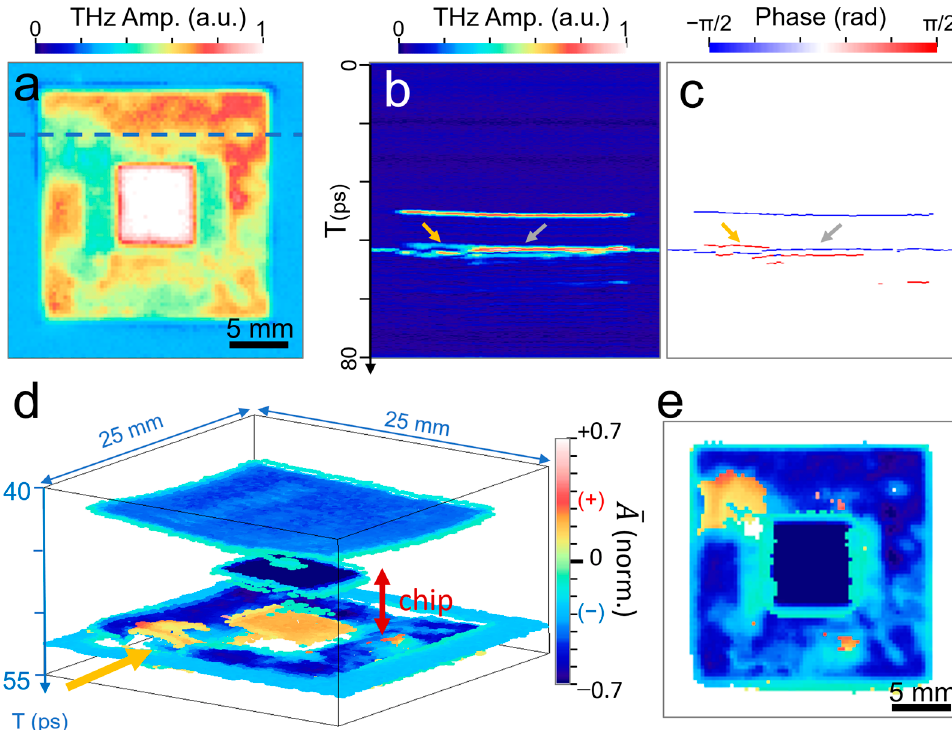
Figure 6. ( a ) Time-integrated C-scan image for a packaged chip with dimensions of 20 mm × 20 mm × 1 mm. ( b ) B-scan image for the reflected amplitude taken along the dashed line in ( a ). ( c ) B-scan image for the phase of the reflected waves. The orange and grey arrows indicate the void and epoxy-rich regions, respectively.( d ) 3D image of reflected amplitudes in terms of the peak envelope modulated with phase polarity. ( e ) C-scan image for the peak envelope with phase polarity for the second peaks appearing in the time domain to highlight the delamination area (red) exclusively.